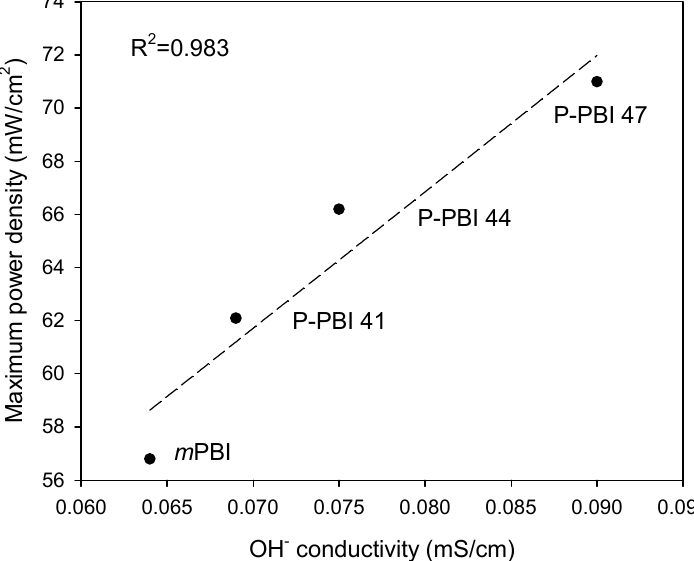
Figure 7. Correlation of maximum power density of MEAs with hydroxide ion conductivity of membranes.